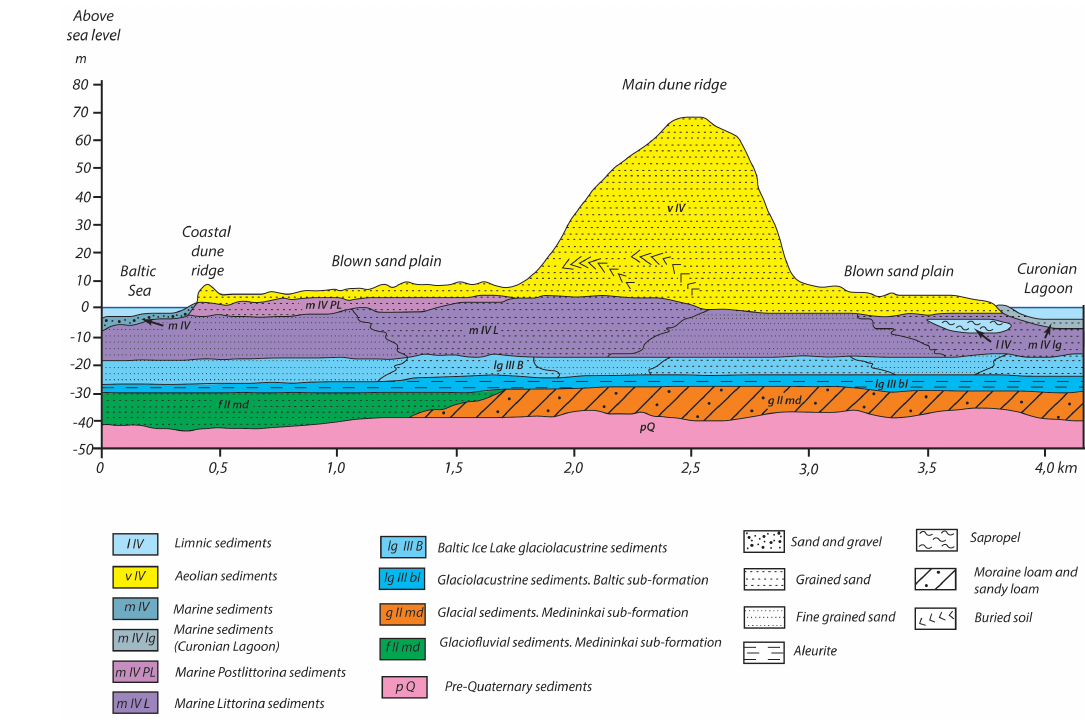
Figure 1. Cross section in the northern part of the Curonian Spit (Vingiakop˙e environment) (by Bitinas et al., 2002; Badyukova et al., 2007).